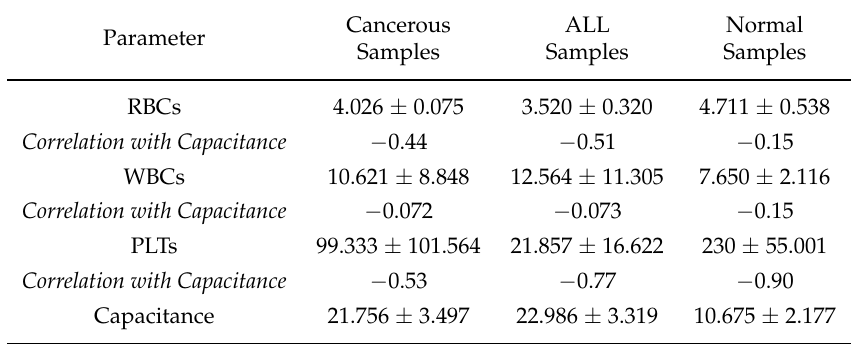
Table 3. The mean and standard deviation value of the blood factors for normal, ALL, and cancerous blood samples. The correlation values between capacitance and individual blood factors are also